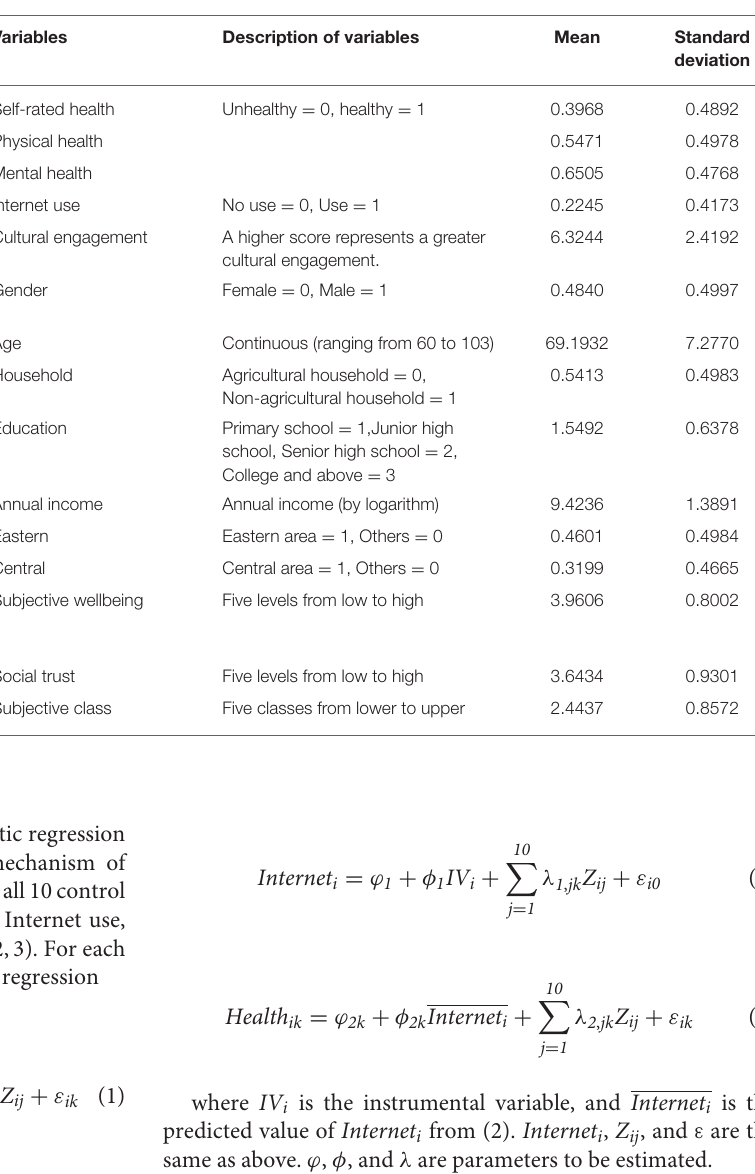
TABLE 1 | Descriptive statistics of all